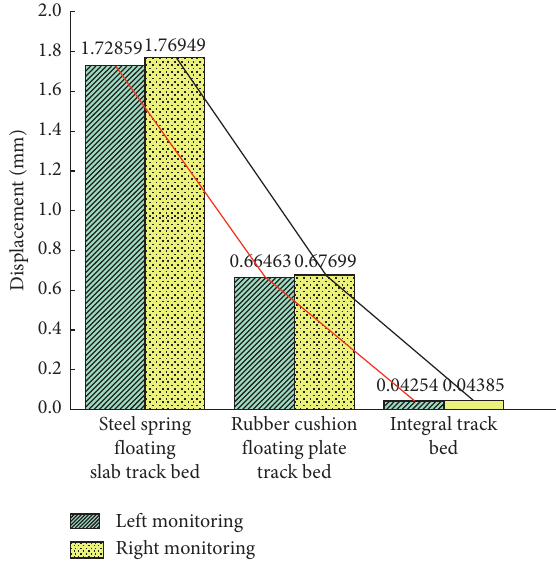
Figure 15: Maximum vertical displacement under different trackbed